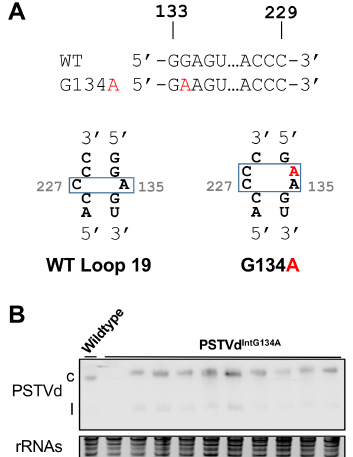
Figure 5. Systemic trafficking analyses on the G134A variant. ( A ) The illustration of WT loop 19 and the corresponding structure of PSTVd IntG134A . The primary sequence alignment is listed on top, with the G134A change highlighted in red; and ( B ) the trafficking capacity of PSTVd IntG134A was demonstrated by their presence in systemic leaves, using Northern blots. rRNAs served as the loading control. c, circular PSTVd. l, linear